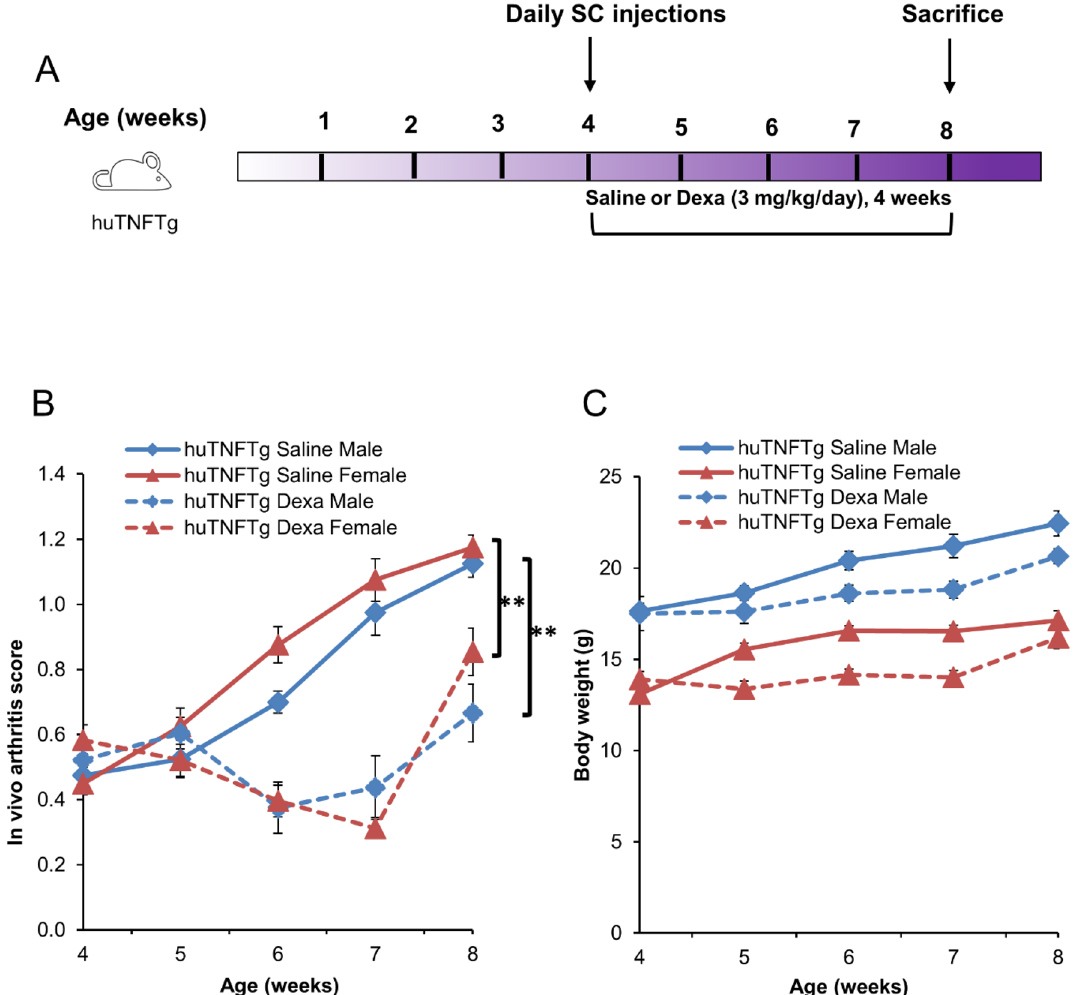
Figure 3. Effect of Dexamethasone (Dexa) on inflammation and body weight in huTNFTg mice (n = 5–6). ( A ) Schematic representation of experimental procedure, showing four-week-old huTNFTg mice treated with Dexa (3 mg/kg/day) or saline for 4 weeks. ( B ) Arthritis scores in male and female huTNFTg mice during 4 weeks treatment with saline or Dexa. ( C ) Body weight in male and female huTNFTg mice administered with Dexa or saline for 4 weeks. Error bars indicate mean ± SEM. Students t-test or Mann–Whitney Rank Sum test was used to analyze differences between groups. ** p <